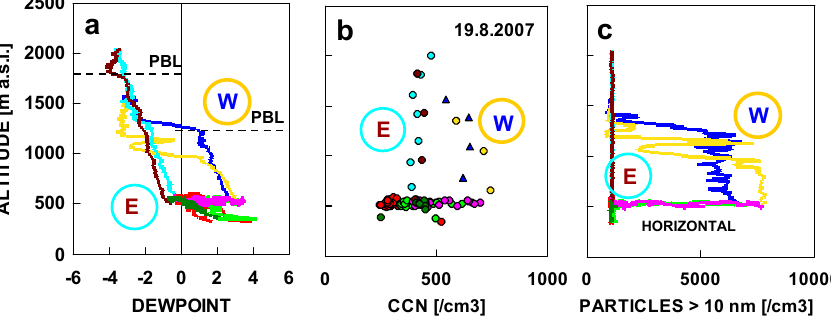
Fig. 4. Dewpoint (water vapour, used to define PBL) (a) , (b) calculated CCN (see text), (c) vertical distributions above the agriculture (W, yellow and blue), and above the natural vegetation (E, light blue and brown) under clear sky conditions. In winter the water vapour over the agriculture is enhanced by increased emissions from the